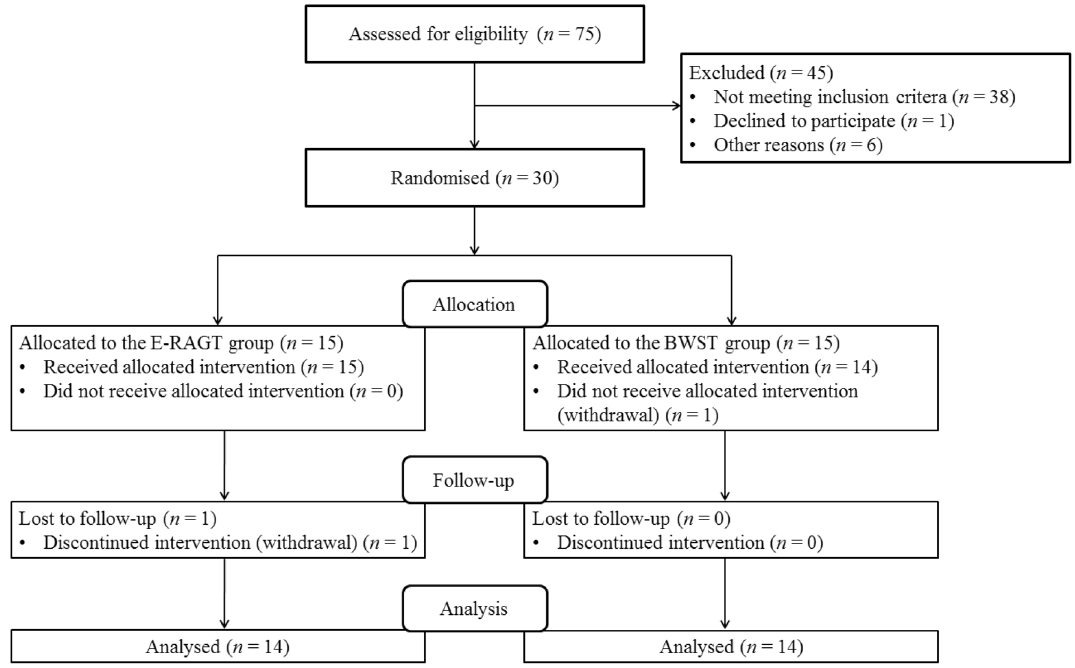
Figure 1. Flow diagram for the study. E-RAGT end-effector robot-assisted gait training, BWST bodyweight- supported treadmill training. E-RAGT ( n = 14) BWST ( n = 14)